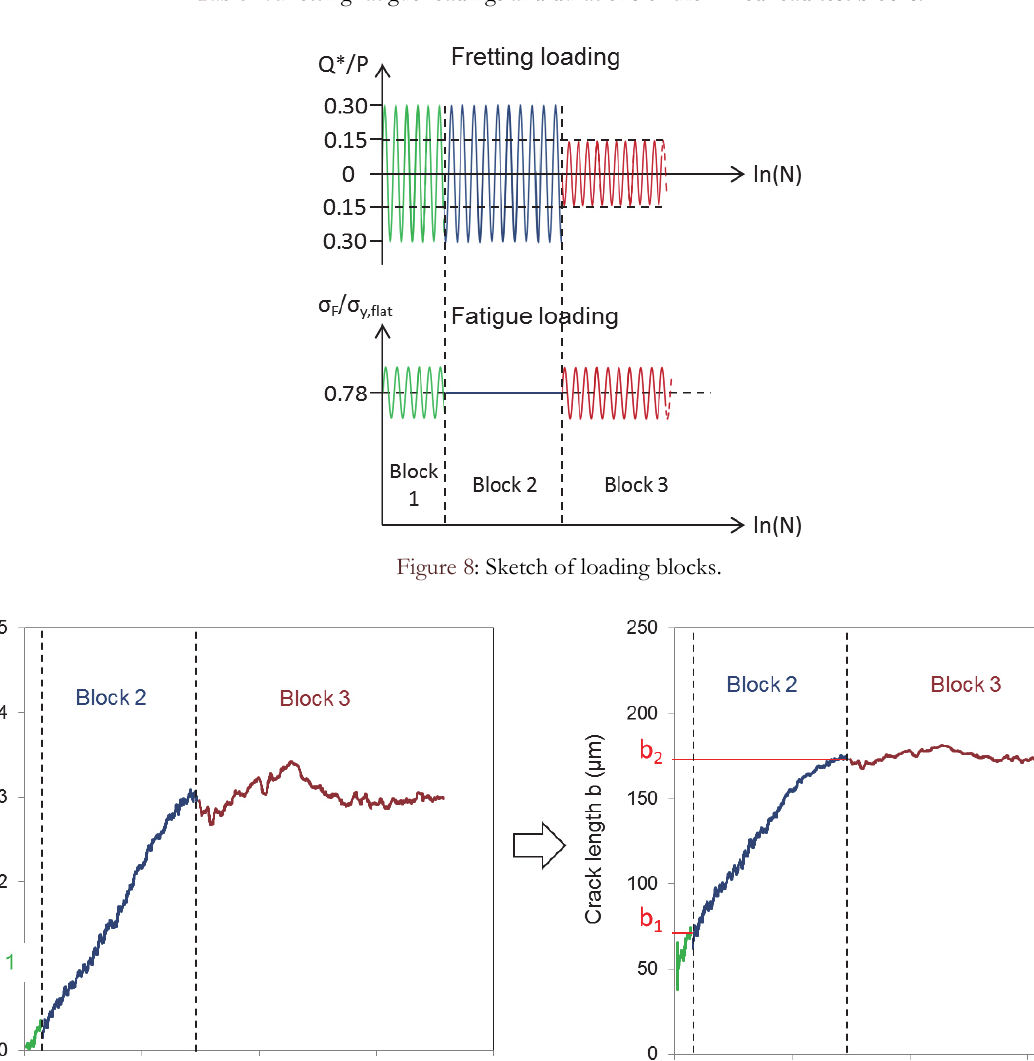
Table 2: Fretting fatigue loadings and durations of the mixed load test blocks.